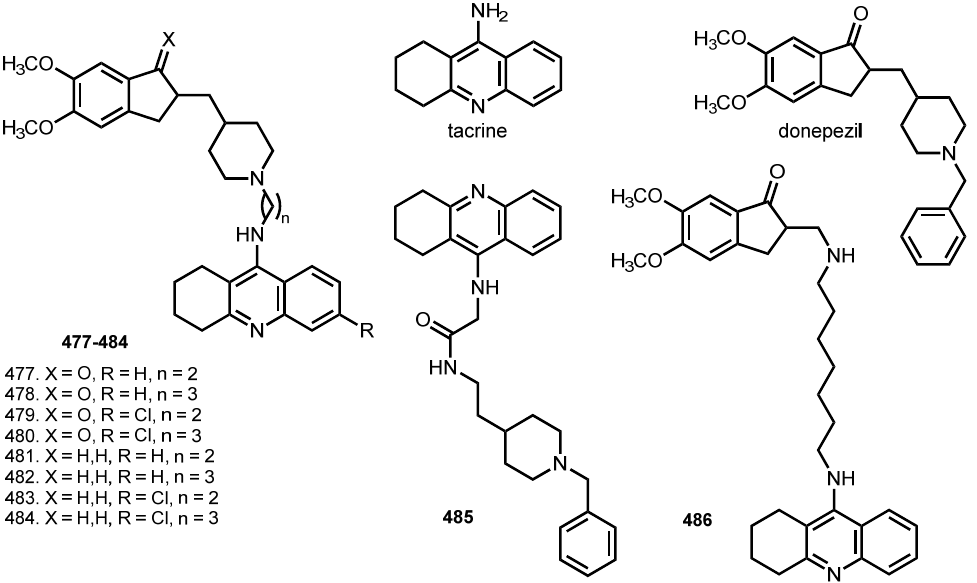
Figure 16. Donepezil, THA, donepezil–THA hybrids 477 – 484 [83], and previously reported donepezil–THA hybrids 485 , 486